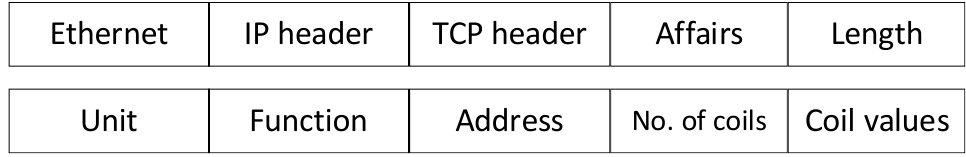
Figure 1. Modbus protocol format.